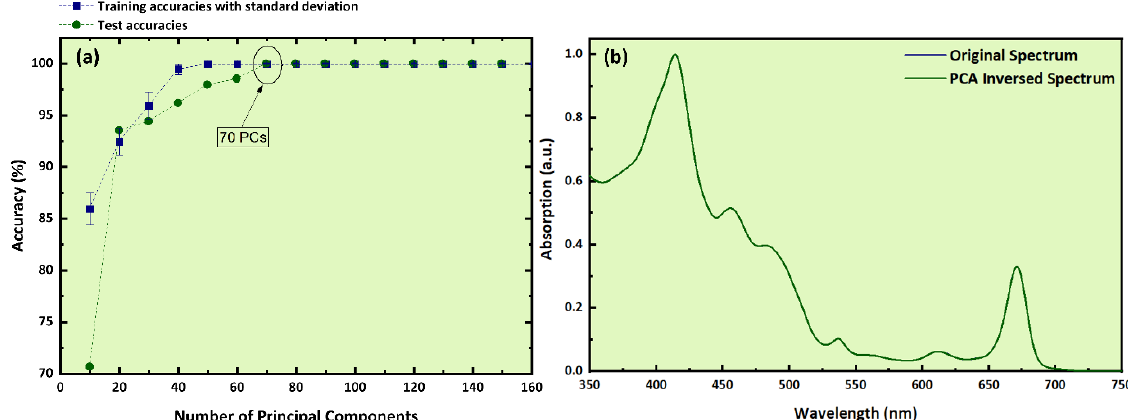
Figure 7. ( a ) Training and test accuracies as a function of the number of PCs, ( b ) experimental absorption spectrum and PCA-inversed spectrum.